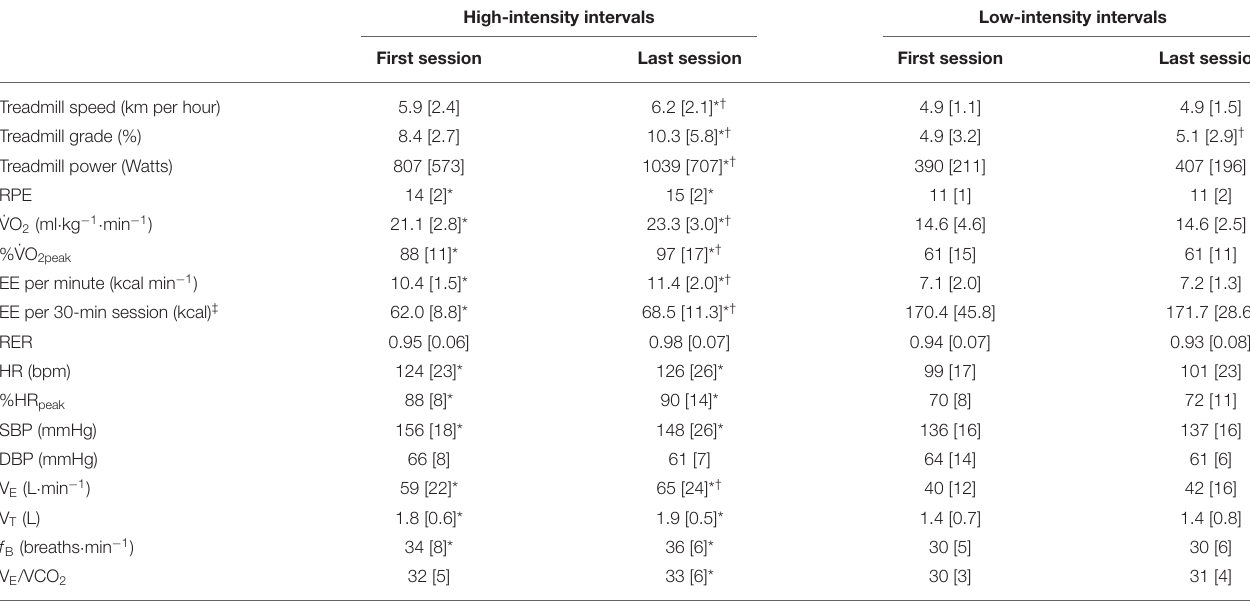
TABLE 2 | Treadmill workload and cardiorespiratory variables during high- and low-intensity intervals. High-intensity intervals Low-intensity